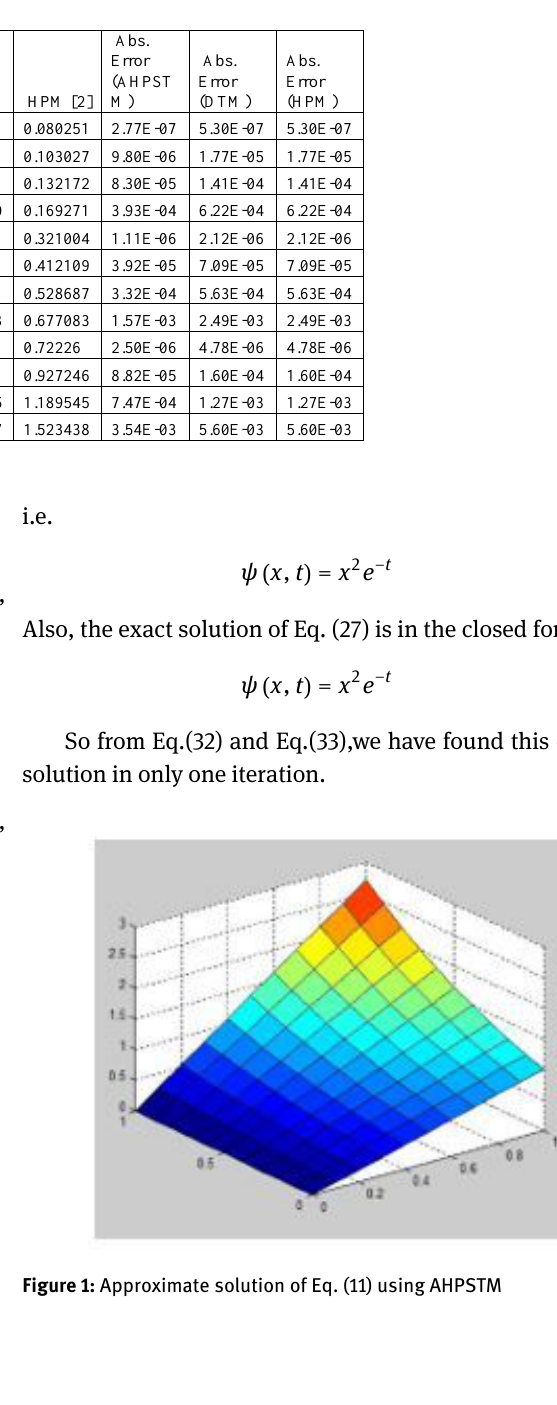
Table 4: Approximate solution of Eq.(19) up to 4 th order approximation